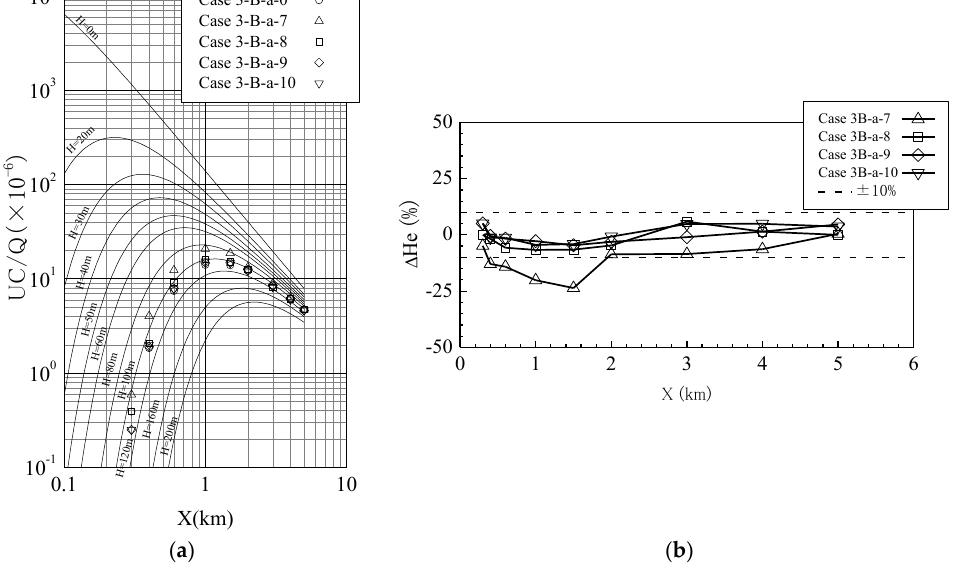
Figure 4. Examples of results of wind-tunnel experiments for BWR site. ( a ) Ground concentrations. ( b ) Relative change in effective stack height.